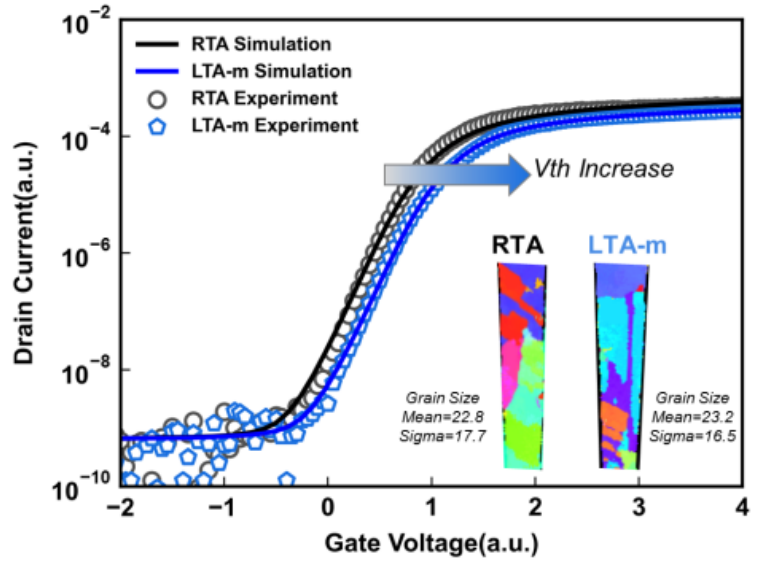
Figure 2. The Id ‐ Vg characteristics of the RTA and LTA ‐ m. The inset is the PED graphs of the cross ‐ section view of the Poly ‐ Si channel with RTA and LTA ‐ m and the grain size mean value of RTA and LTA ‐ m.